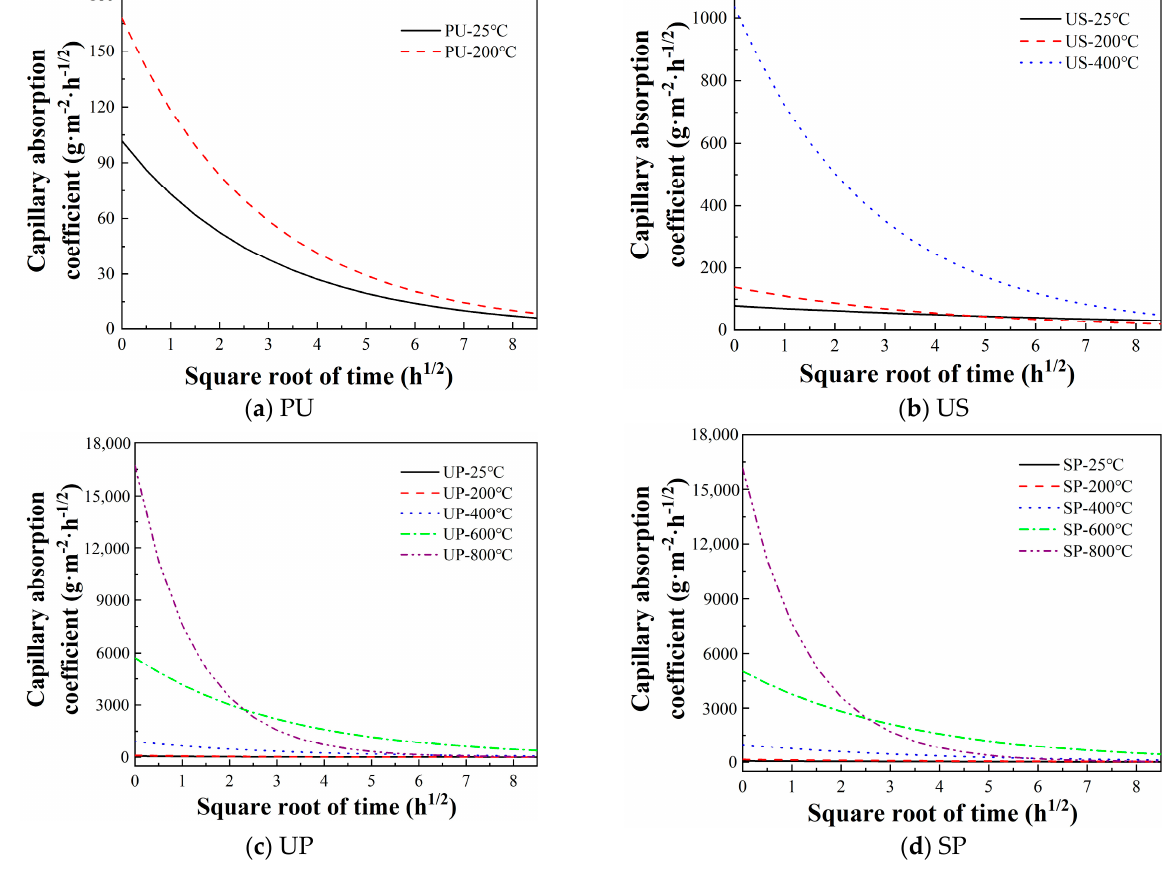
Figure 10. Capillary water absorption coefficient curves after exposure to high temperatures.